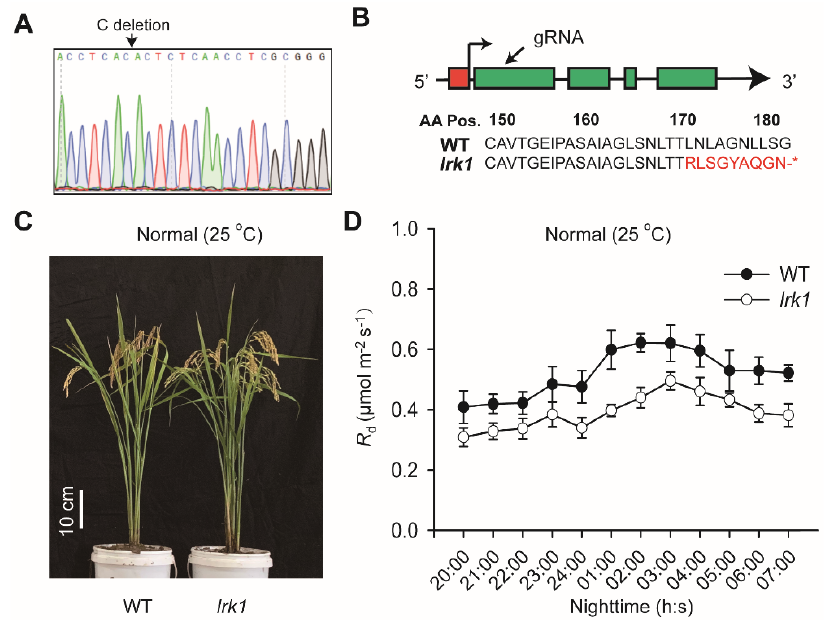
Figure 5. Biological function of knock-out lines of LRK1 . ( A ) DNA sequencing of CRISPR-CAS9 edited LRK1 , designated lrk1 . The arrow indicates the mutation site. ( B ) Target of gRNA in lrk1 . The arrow indicates the position of guide RNA (gRNA) target. Amino acid (AA) changes due to CRSIPR-CAS9 led to a single “C” allele deletion at 508th nucletide (170th AA), and stop codon at the 180th AA in lrk1 . ( C ) Performance of WT and lrk1 mutant grown in GR under ambient temperature (25 ◦ C) and the vertical white bar displays the scaling bar of 10 cm length. ( D ) R d dynamics during nighttime in 60-day old plants of WT and lrk1 mutant grown in GR at 25 ◦ C. Each data point represents the mean of six different replicates performed on different plants ±SE.